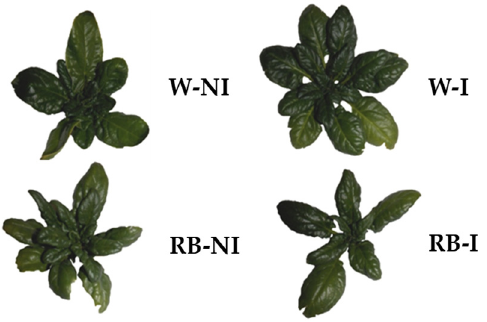
Figure 1. Representative images of not-inoculated (NI) and inoculated (I) spinach plants grown under W and RB light regimes.